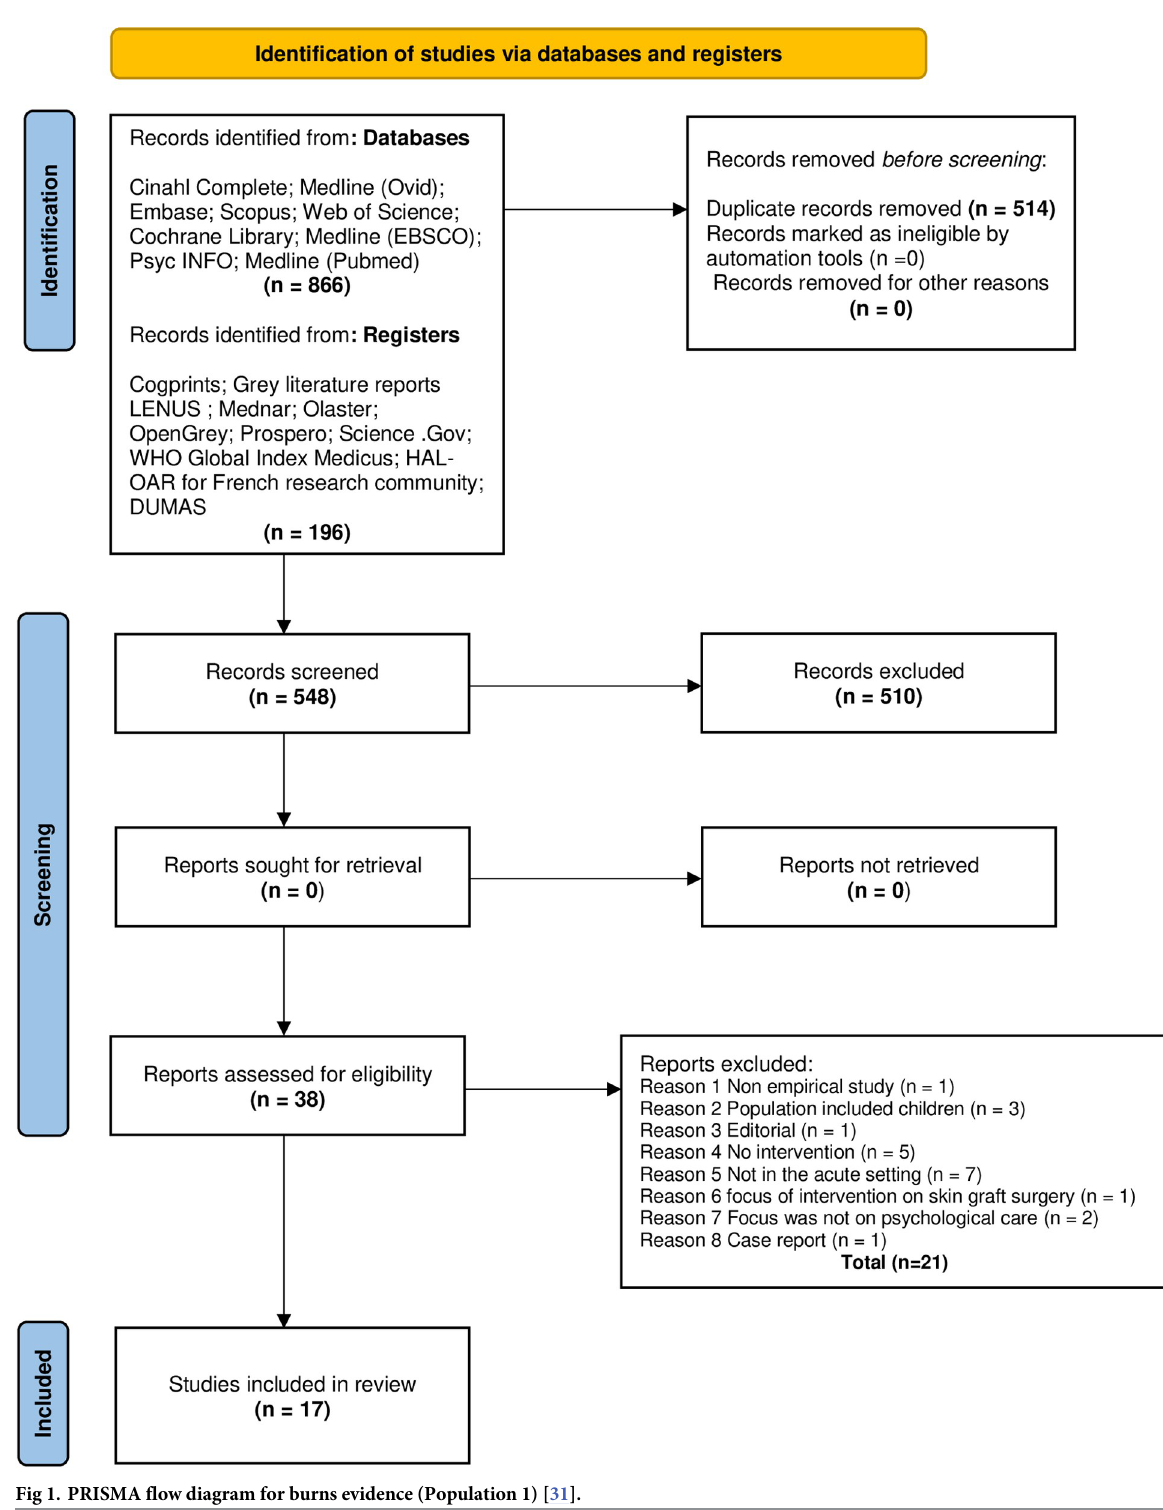
Fig 1. PRISMA flow diagram for burns evidence (Population 1) [31].